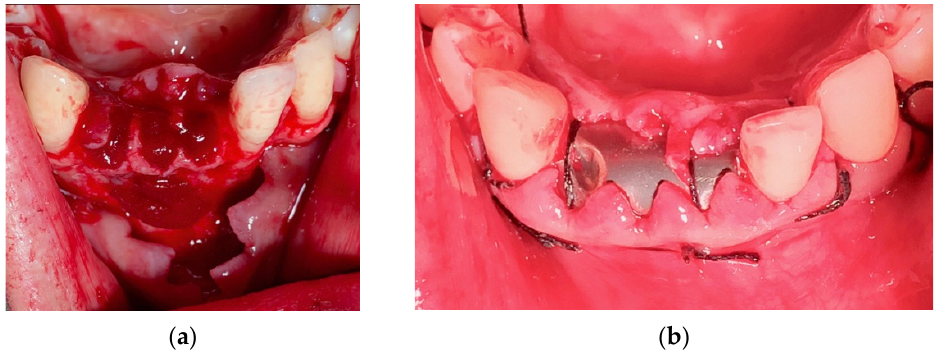
Figure 14. ( a ) Extraction site filled with collagen sponges; ( b ) titanium foil and suture.